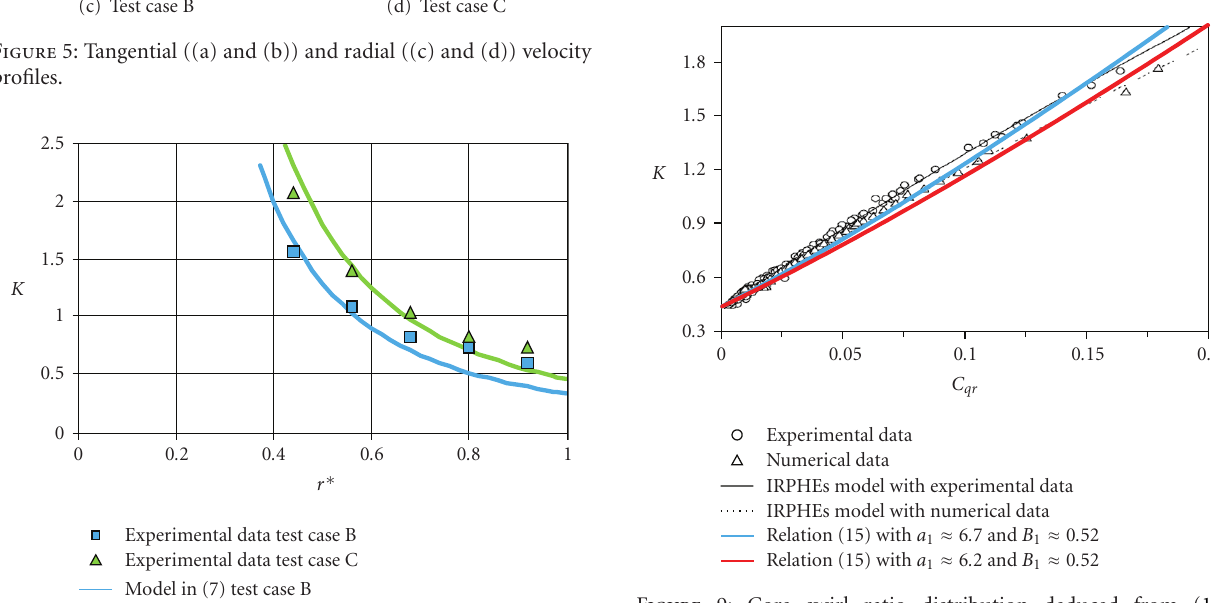
Figure 9: Core swirl ratio distribution deduced from (15).